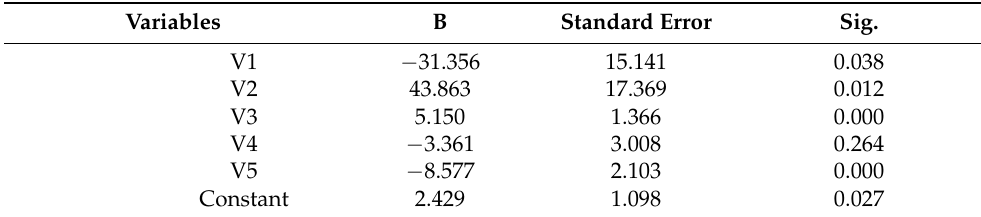
Table 3. Summary of the logistic regression model.